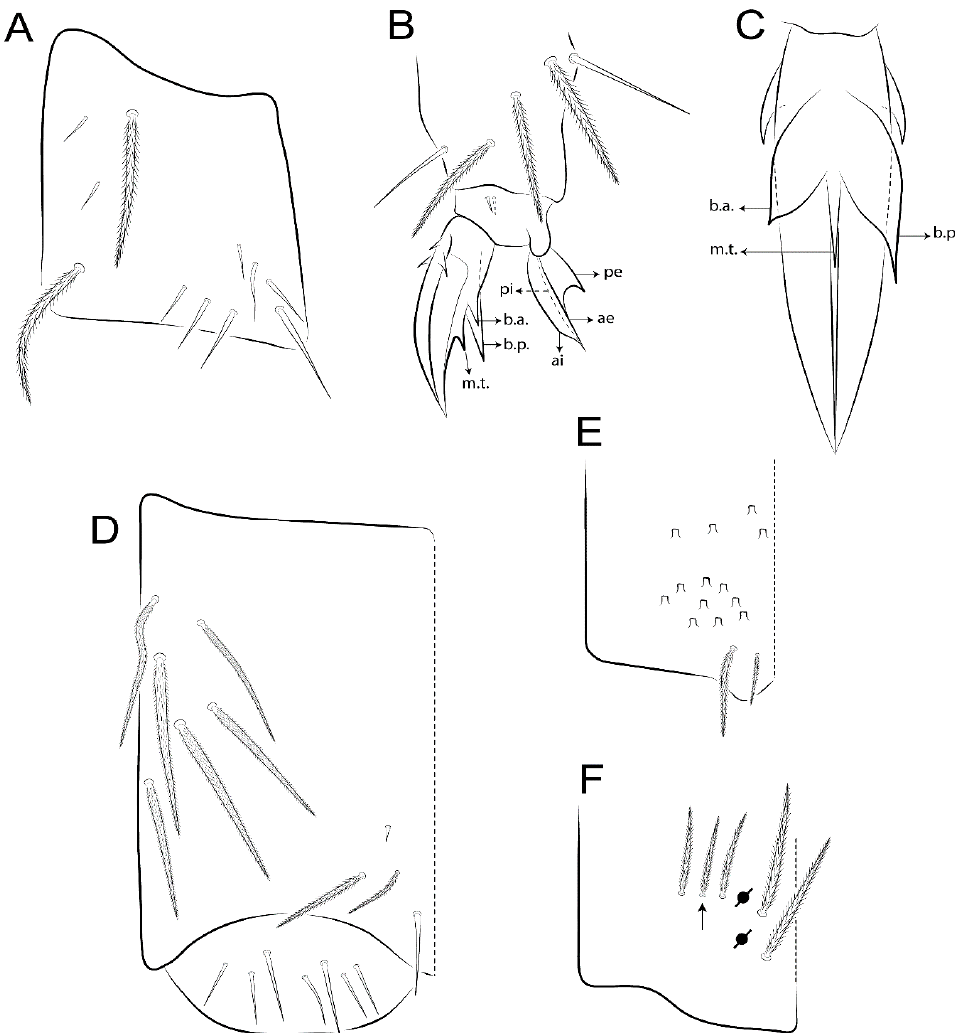
Figure 30. Pseudosinella serpentinensis sp. nov.: trunk appendages. ( A ) trochanteral organ; ( B ) distal tibiotarsus and empodial complex III (anterior view); ( C ) unguis (inner view); ( D ) collophore (lateral view); ( E ) distal part of manubrium (ventral view); ( F ) manubrial plate (dorsal